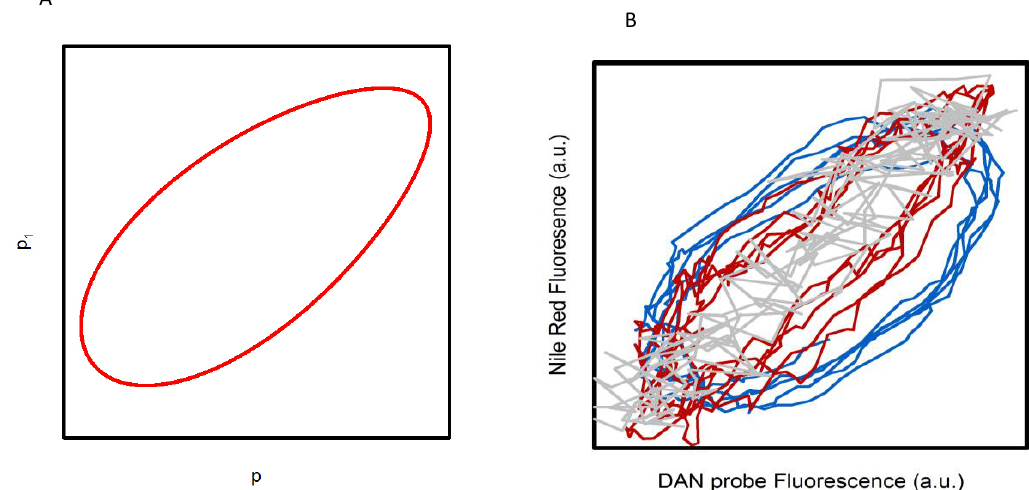
Figure 2. Oscillations in the polarization of water in aqueous environments with glycolytic oscillations may induce oscillations in (lipid-rich membranous) regions where no biochemical oscillations are expected to appear. ( A ) Theoretical phase plot of oscillations of polarization of water in a region with no glycolytic oscillations (p 1 ) against the polarization of water in a region with glycolytic oscillations (p) generated by a Yang-Ling isotherm-based model of glycolytic oscillations. ( B ) Phase plot of Nile red fluorescence against the fluorescence of the three DAN probes: ACDAN (blue), PRODAN (red), and LAURDAN (grey). Reproduced from [13] and [15].